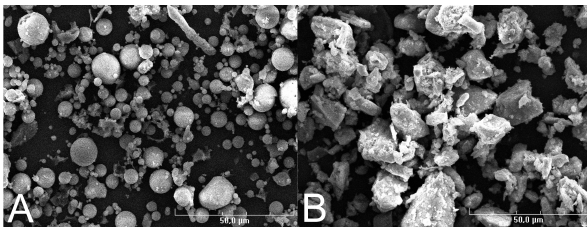
Fig. 1. SEM (Scanning Electron Microscopy) pictures of anthro- pogenic coal ash dust (A) and of natural loess from Cape Verde (B) . Pictures obtained with the collaboration of the Electronic Mi- croscopy Group, Universit´e de Bretagne Occidentale, Brest,